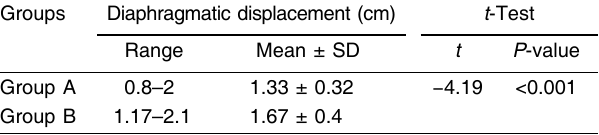
Table 5 Comparison between group A and group B regard diaphragmatic displacement Groups